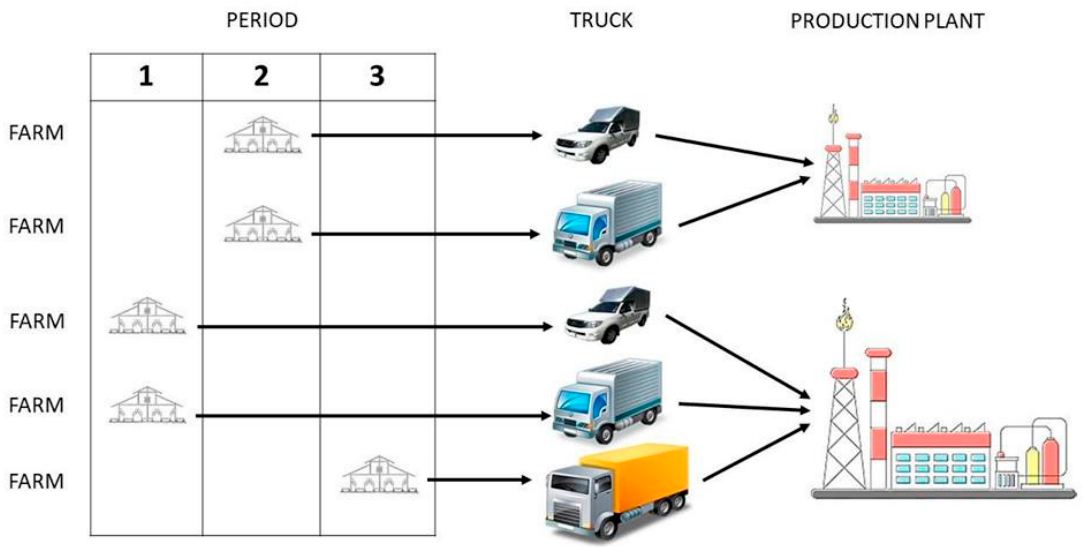
Figure 1. Supply chain of farms and production plants.